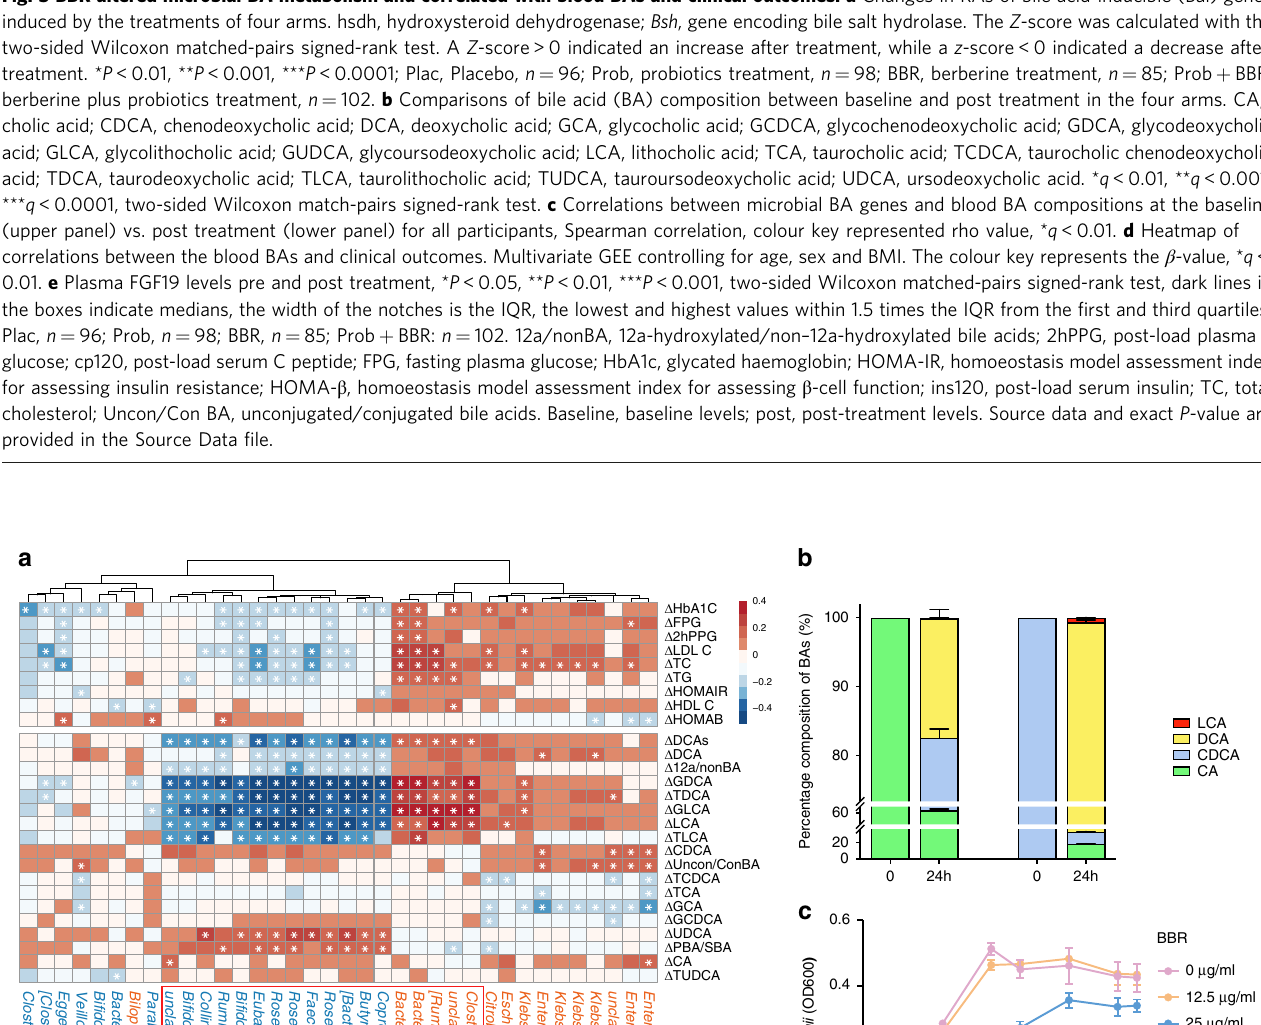
Fig. 4 R. bromii was inhibited by BBR to attenuate DCA transformation. a The two-panel heatmap on the left shows the correlations between the key BBR responsive species and with major clinical outcomes and plasma levels of bile acid. The colour key shows Rho calculated by partial Spearman ’ s correlation with adjustment for age, sex and BMI. Δ of clinical parameters or BAs = 100% × (baseline value − post treatment value)/baseline value. Species in blue represent depleted species and species in orange represent enriched species after BBR treatments. * P < 0.05. b Bile acid transformation assay for R. bromii . The percentage composition of deoxycholic acid (DCA) and lithocholic acid (LCA) in the culture media with which R.bromii had grown for 24 h with primary bile acid (CA and CDCA) treatment were measured by LC/MS. n = 3, data are shown as the mean ± SD. c The growth curve of R. bromii with different concentrations of BBR in the in vitro culture experiment, demonstrated a signi fi cant inhibitory effect of BBR on R. bromii starting at a concentration of 25 μ g ml − 1 , n = 3, P < 0.001, determined by two-way repeated-measures ANOVA, data are shown as the mean ± SD. Bi fi dobacterium catenulatum − Bpc , B. catenulatum – Bi fi dobacterium pseudocatenulatum complex . Source data and exact P -value are provided in the Source Data fi